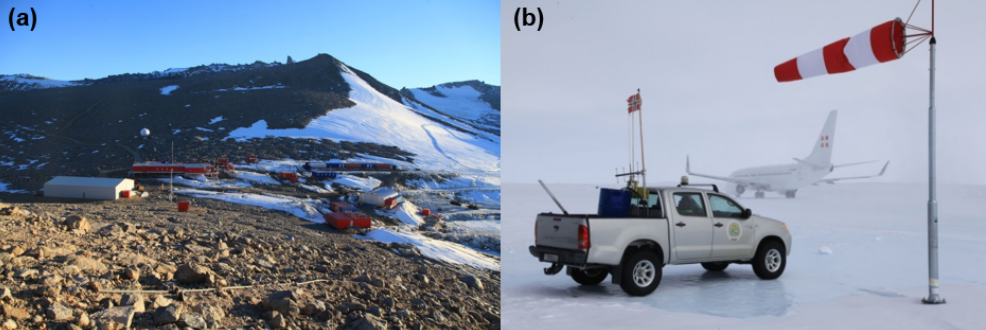
Figure 2. Troll Station (a) and Troll airfield (b) with a parked Boeing 737 aircraft. Credits: Sven Lidström (Norwegian Polar Institute).